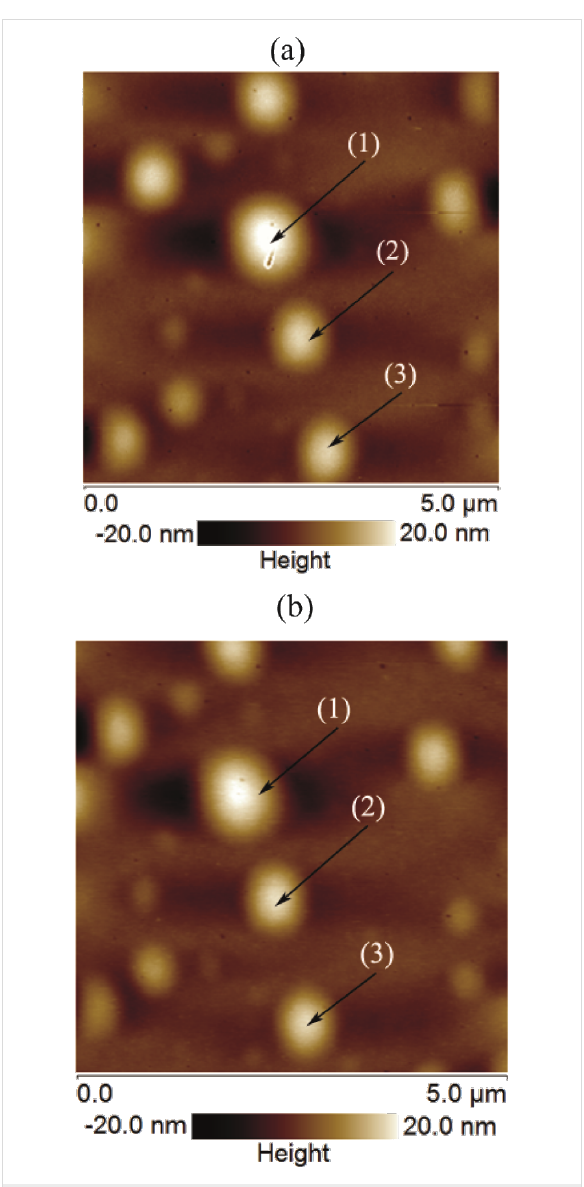
Figure 5: Height images of spherical objects on PS-coated surfaces obtained using (a) contact mode (b) tapping mode at 90% set point